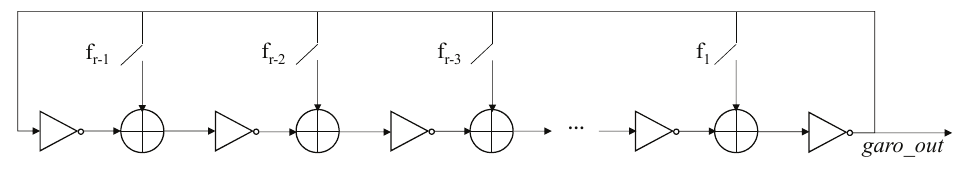
Figure 2: The structure of